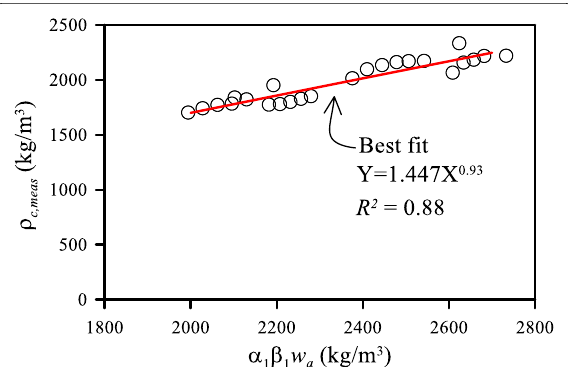
Fig. 1 Relationship of ρ c,meas and w a multiplied by coefficient factors.